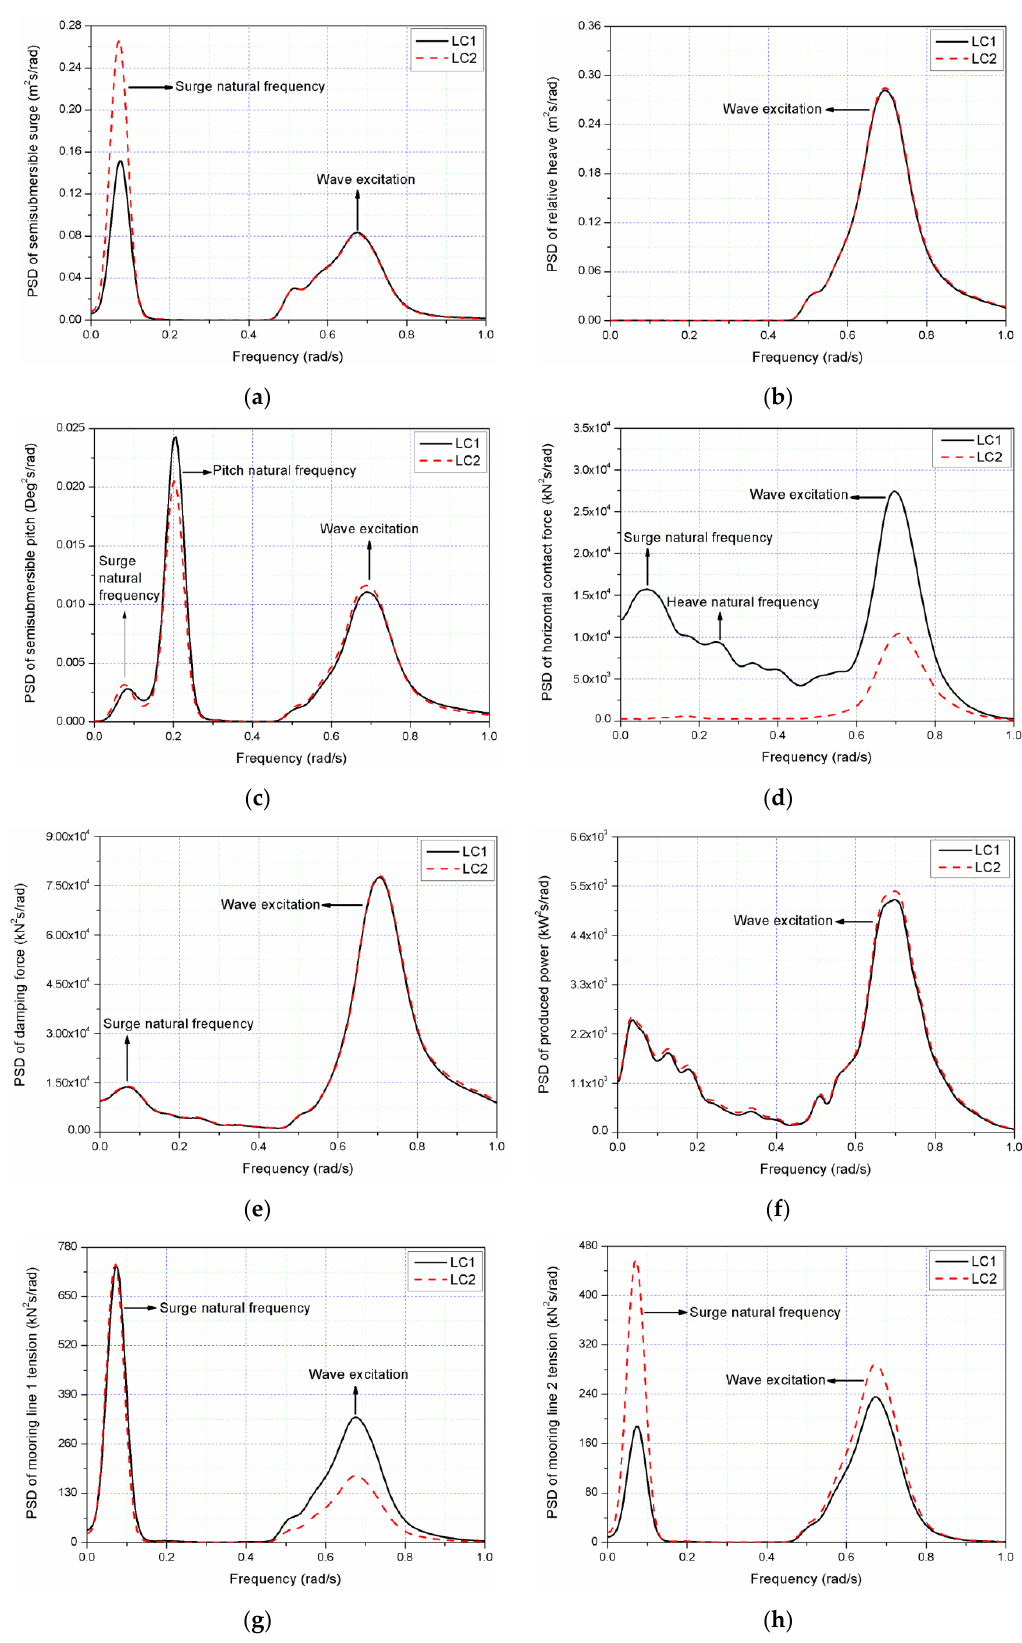
Figure 16. Comparisons of the PSD of the motion and dynamic responses for LC1 and LC2: ( a ) semisubmersible surge; ( b ) relative heave; ( c ) semisubmersible pitch; ( d ) horizontal contact force; ( e ) damping force; ( f ) produced power; ( g ) mooring line 1 tension; ( h ) mooring line 2 tension.